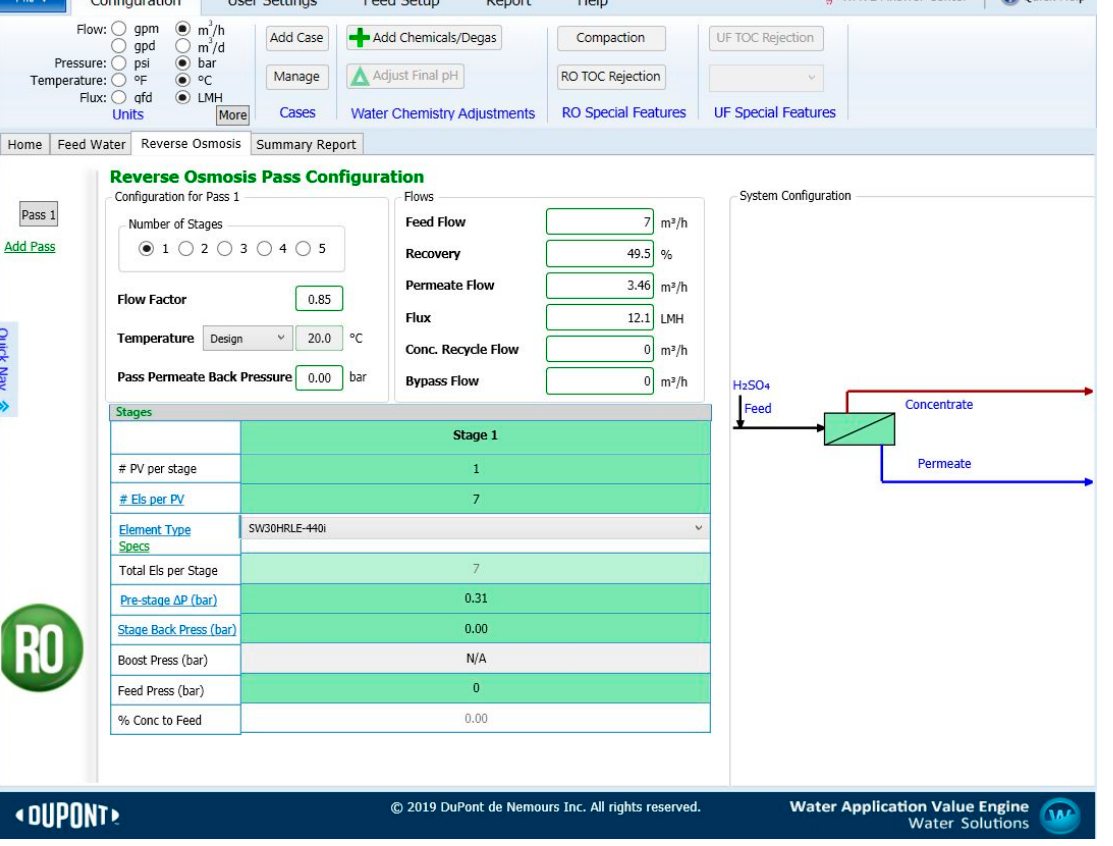
Figure 3. Screenshot of “Reverse Osmosis” (WAVE software). 2019.